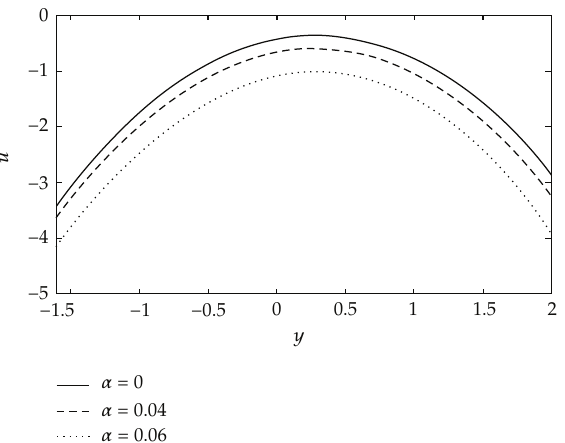
Figure 8: Axial velocity versus y at a (cid:9) 0 . 2 , b (cid:9) 0 . 6 , d (cid:9) 0 . 8 , ε (cid:9) 0 . 2, λ 1 (cid:9) 1 , Da (cid:9) 1, x (cid:9) π/ 6, q (cid:9) − 1, and φ (cid:9) π/